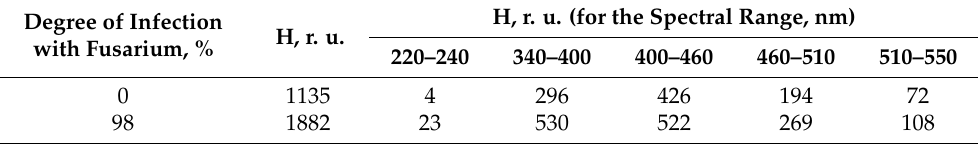
Table 2. Integral parameters of the excitation spectra of wheat seeds of various degrees of Fusarium infection.